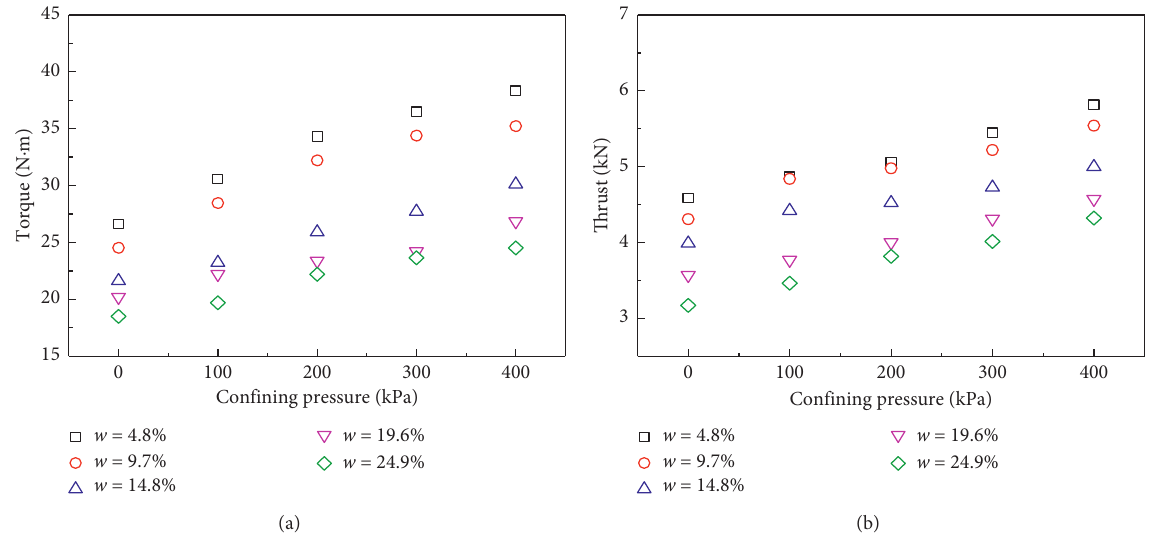
Figure 8: Patterns in changes of rotary drilling parameters under influence of water content and confining pressure: (a) torque and (b)